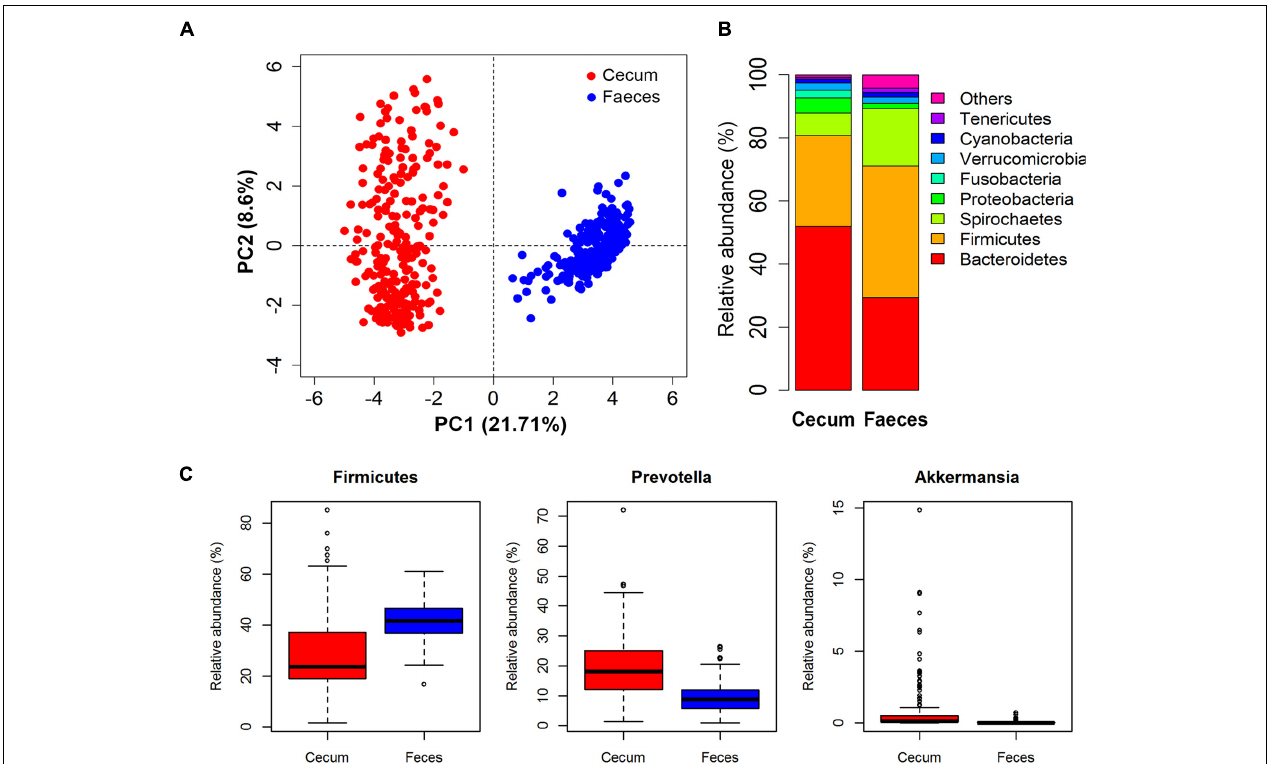
FIGURE 2 | Comparison of the microbial composition between two types of samples and among individuals within population with 16S rRNA gene sequencing data. (A) PCA analysis showed great difference of microbial composition between cecum lumen and feces; (B) Comparison of microbial composition at the phylum level; and (C) Distribution of relative abundances of bacterial genera among individuals. Samples/bacterial genera are represented along the horizontal axis, and relative abundance is denoted by the vertical axis.